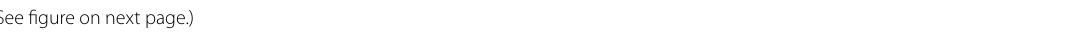
SE of 4 independent ±